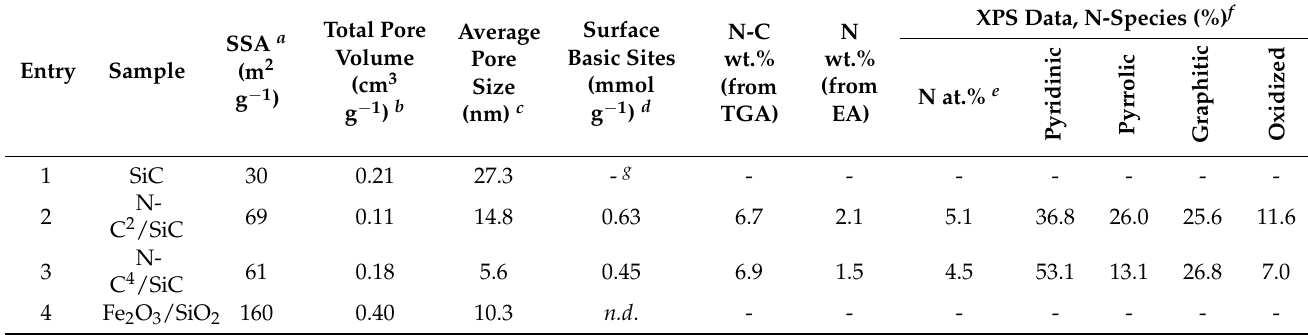
Table 1. Selected chemico-physical and morphological properties of catalysts and